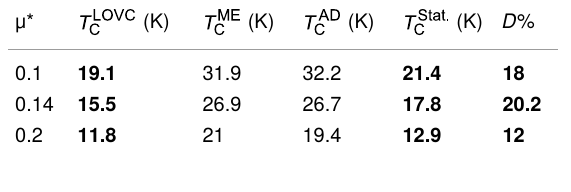
Table 1: Critical temperature estimated from the LOVC model, from the ME model, using the Allen–Dynes formula [80], and from the ana- lytical model including static corrections ( ). Additionally, the values of the D parameter were given.